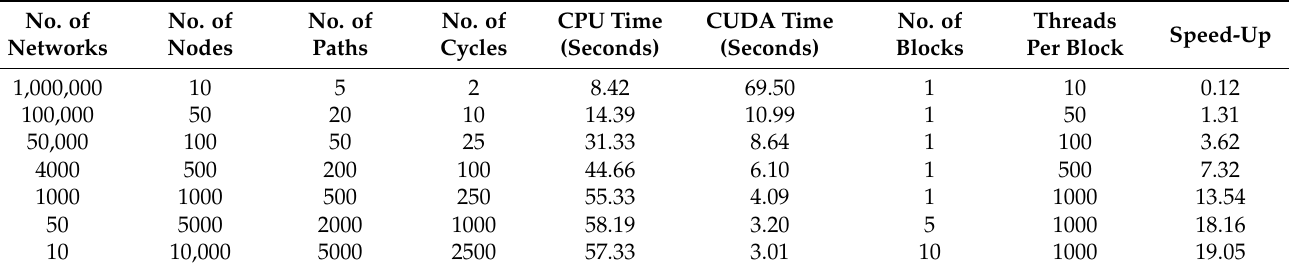
Figure 3. Networks generated using AGRFN. ( a ) Network with n = 6, npath = 3, ncycle=2; ( b ) network with n = 20, npath = 10, ncycle = 2; ( c ) network with n = 100, npath = 20, ncycle = 10. Table 1. Random network generation and running time